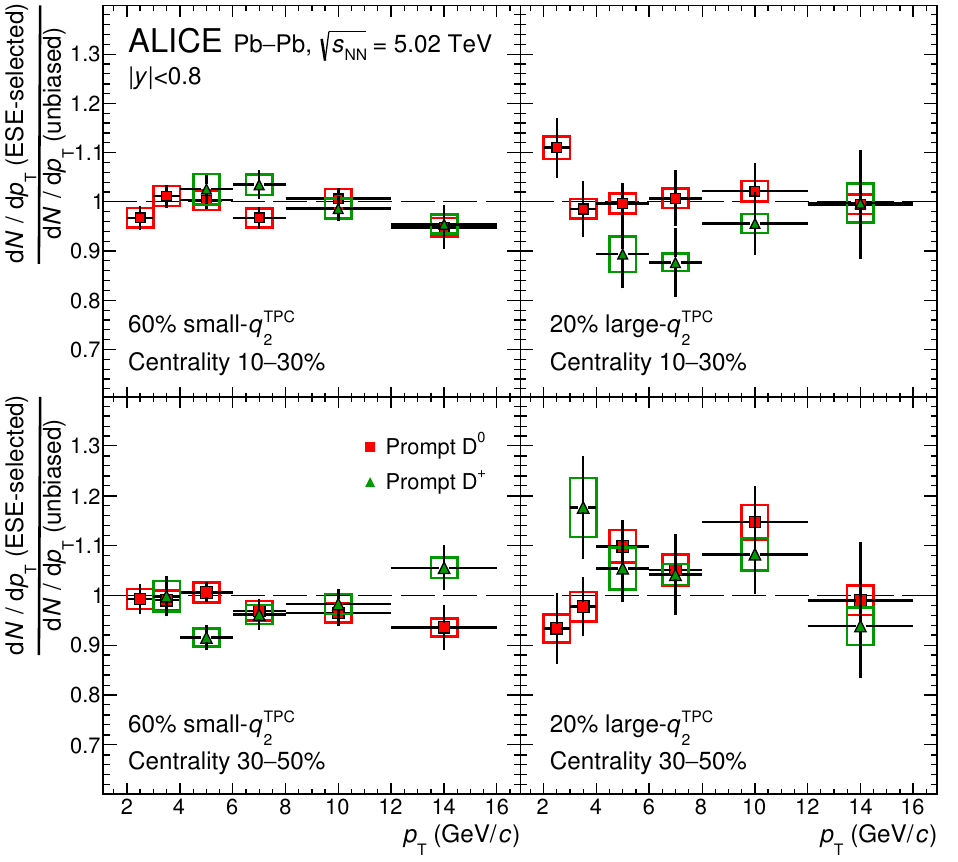
Figure 10 . Ratio of the yields of D 0 and D + mesons measured as a function of p T in the small- q TPC (left column) and large- q TPC (right column) samples (see text for details) to that in the unbiased 2 p sample, in Pb-Pb collisions at s = 5 : 02 TeV for the 10{30% (top row) and 30{50% (bottom NN row) centrality classes. Vertical error bars represent the statistical uncertainty, empty boxes the total systematic